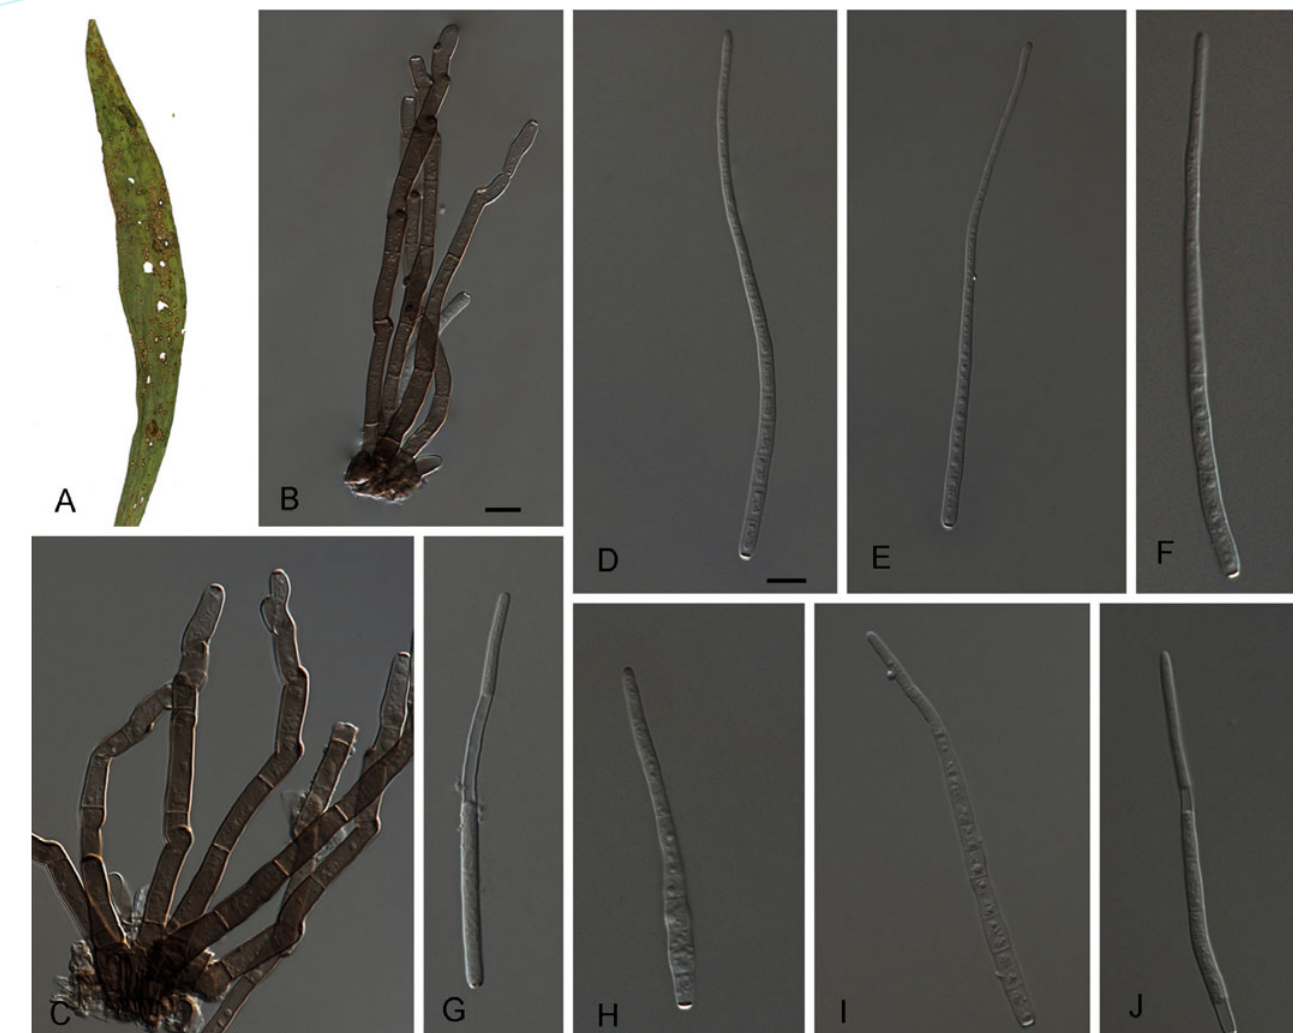
Fig. 3. Cercospora plantaginis (cid:2)(cid:24)%=%(cid:2)*9"!+(cid:27)(cid:28)(cid:2) A. S(cid:13)(cid:9)(cid:26)(cid:2)(cid:7)(cid:18)(cid:4)(cid:8)(cid:7)(cid:28)(cid:2) B–C. 2(cid:9)(cid:7)(cid:19)(cid:11)(cid:19)(cid:5)(cid:23)(cid:9)(cid:8)(cid:13)(cid:2)(cid:19)(cid:4)(cid:17)(cid:11)(cid:21)(cid:11)(cid:4)(cid:18)(cid:14)(cid:4)(cid:10)(cid:13)(cid:7)(cid:28)(cid:2) D–J.